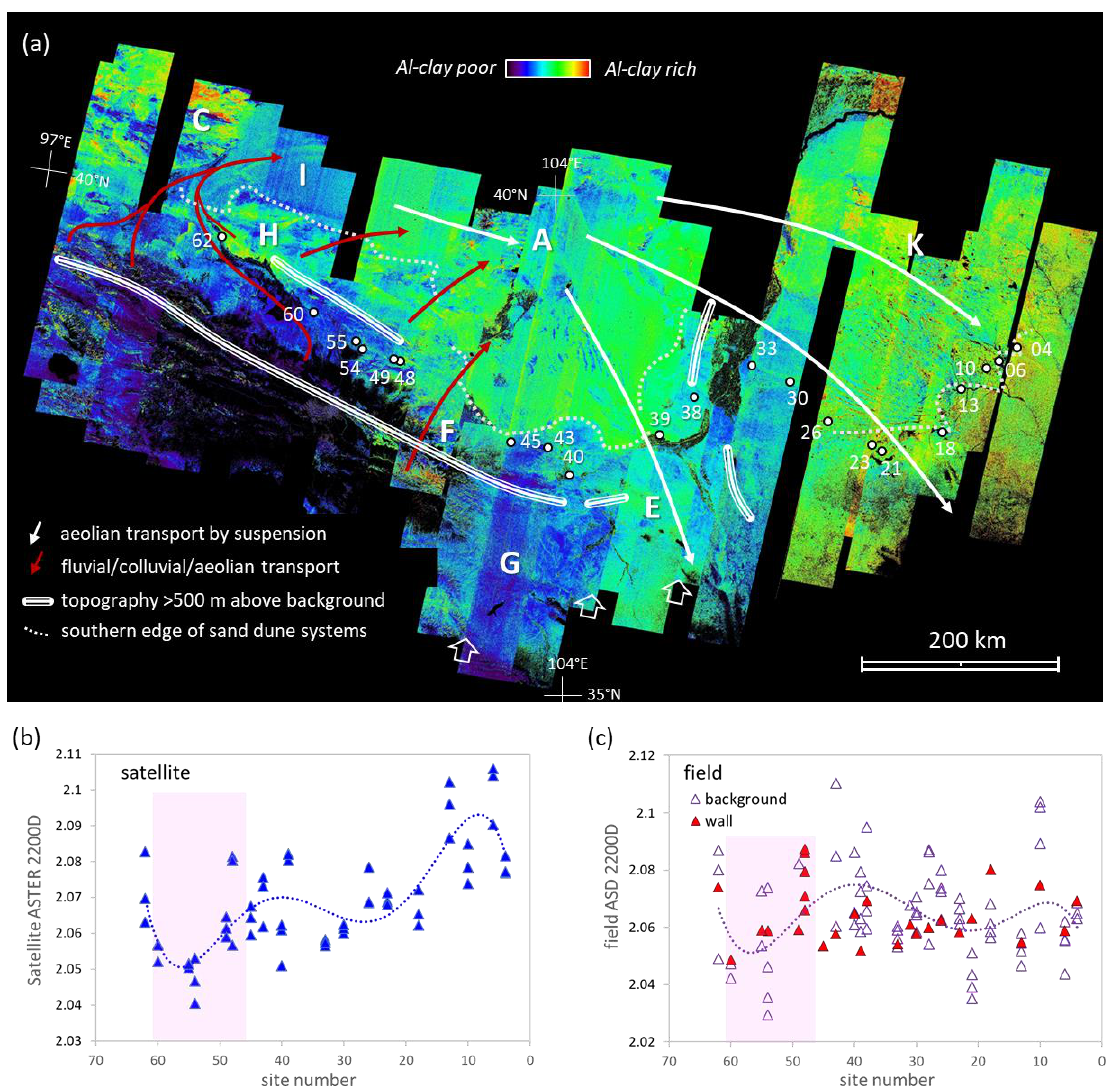
Figure 5. ( a ) Satellite ASTER 2200D index base-map depicting the amount of Al-bearing minerals (i.e., muscovite/illite, kaolinite) with greater abundances in warmer tones. ( b ) Scattergram of the west-to-east spatial trend of satellite ASTER 2200D responses of ROIs collected from three (north, south, and centered over the wall) ROIs (~50 pixels each) of the field sites. ( c ) Scattergram of the west-to-east spatial trend of field 2200D responses of both wall (filled red triangles) and background (open red triangles) samples. Fifth-order polynomials are fitted to the satellite and background field sample data. A magenta box highlights the well- preserved “Shandan” wall section.